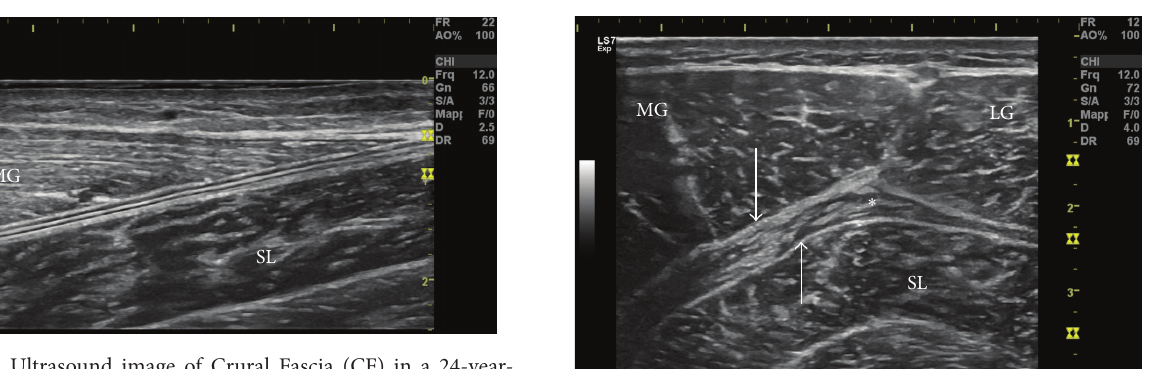
Figure 1: Ultrasound image of Crural Fascia (CF) in a 24-year- old male volunteer. The CF is easily distinguishable by the epimysia of the medial gastrocnemius (MG) and soleus (SL) being between these three structures (hyperechoic) interposed by two layers of hypoechoic connective tissue.